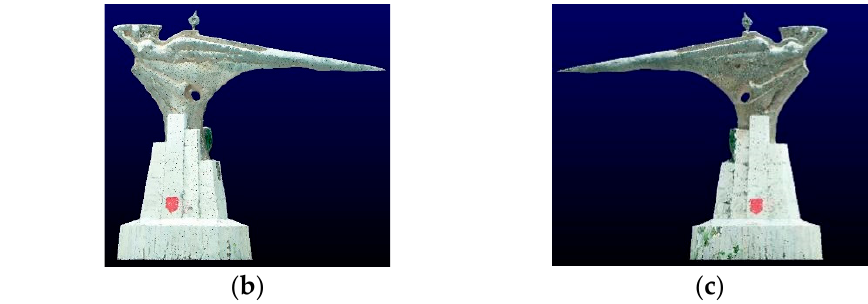
Figure 6. UAS photogrammetric point cloud projection view obtained by the laboratory. ( a ) Top view. ( b ) Front view. ( c ) Rear view.